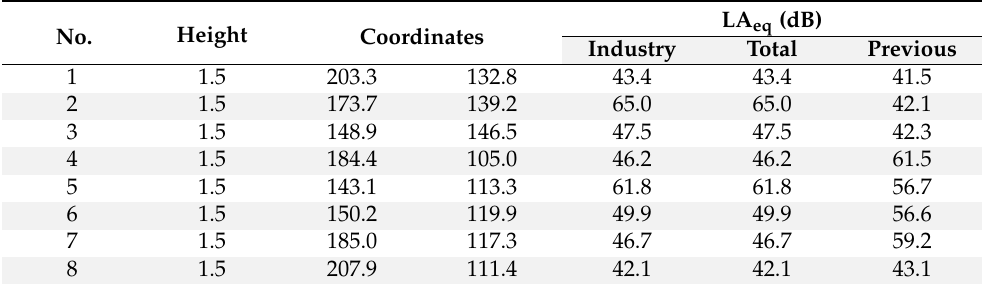
Table 21. Expected sources of construction